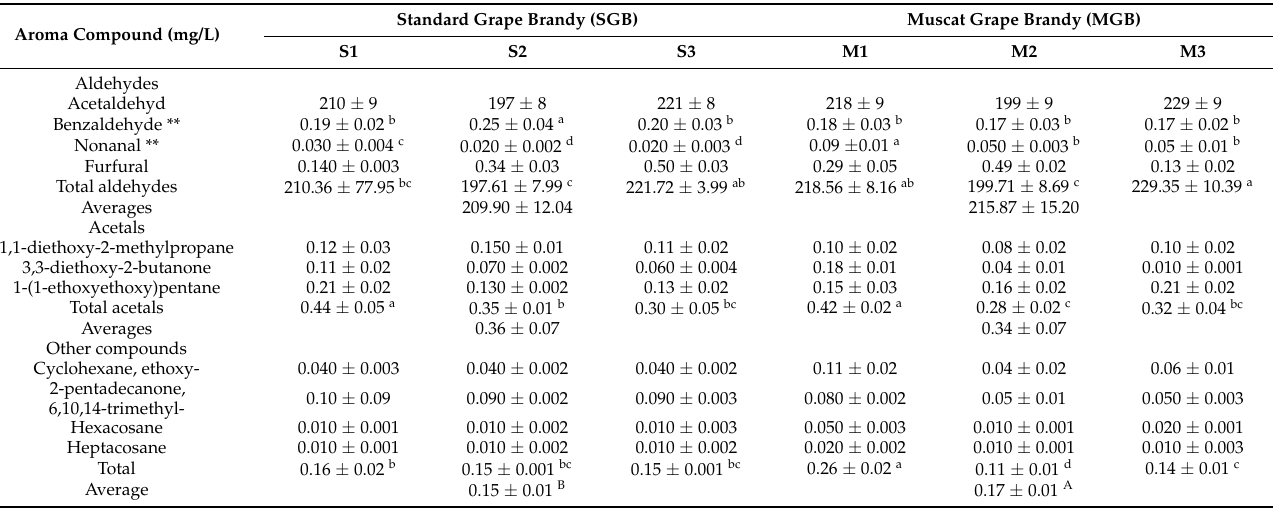
Table 5. Concentration of aldehydes, acetals, and other compounds in standard and Muscat grape brandies in mg/L